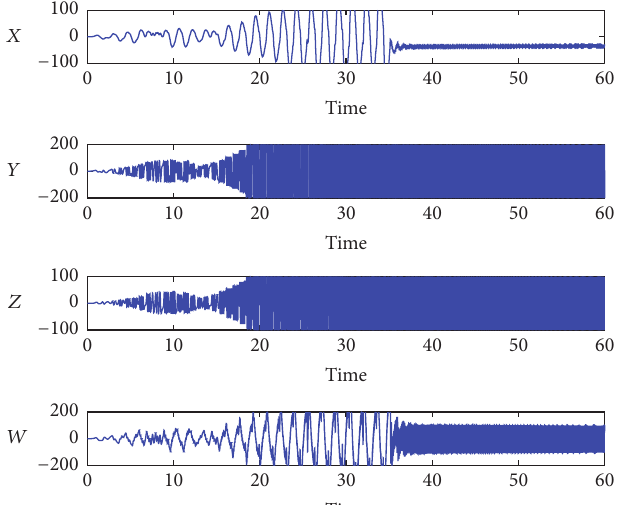
Figure 15: Temporal evolution in the chaotic-transient solutions.